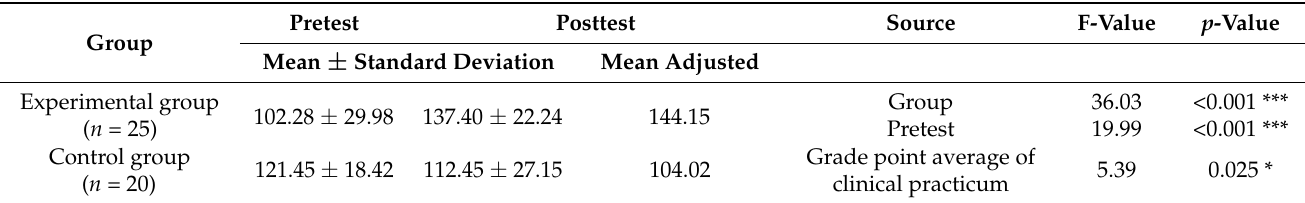
Group 36.03 <0.001 *** Pretest 19.99 <0.001 *** Grade point average of 5.39 0.025 * clinical practicum